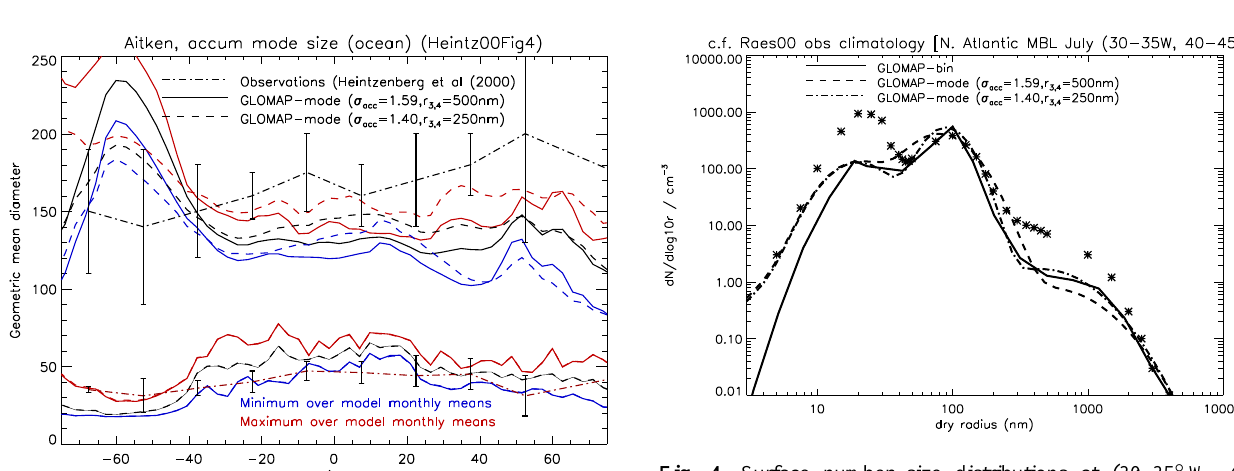
Fig. 4. Surface number size distributions at (30–35 ◦ W, 40– 45 ◦ N) as simulated by GLOMAP-bin (solid), the standard (v6I) GLOMAP-mode run (dashed) and improved (v6R) GLOMAP- mode run (dot-dashed). The observations (asterisks) represent the July climatological size distribution reported for clean marine air masses in Raes et al. (2000). Model lines are July means over the range 30–35 ◦ W, 40–45 ◦